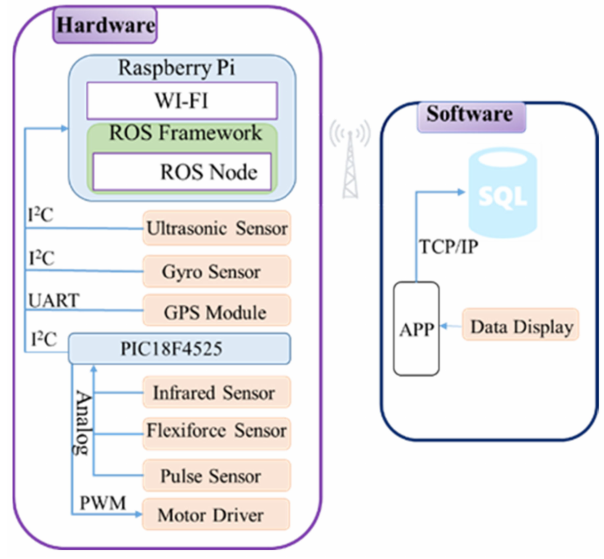
Figure 1. Proposed smart walker architecture.